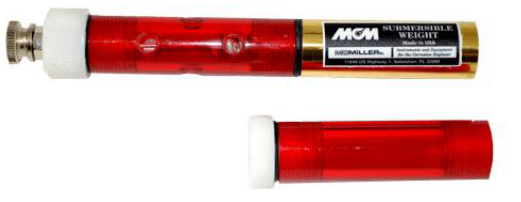
Figure 9. A portable silver chloride Ag/AgCl/saltwater electrode intended for installation within the protection system.